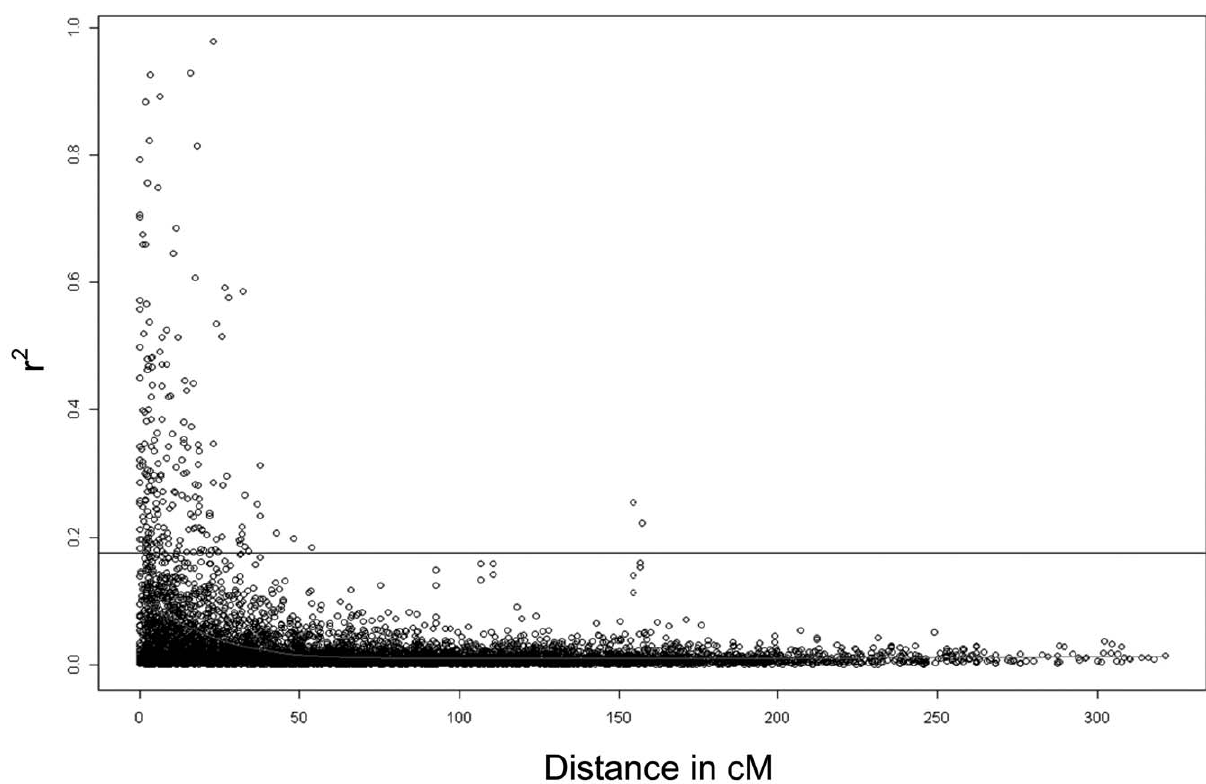
Figure 2. Linkage disequilibrium represented as r 2 of marker pairs versus genetic distance in centiMorgan over all chromosomes. The horizontal line marks the threshold above which LD is likely due to genetic linkage.